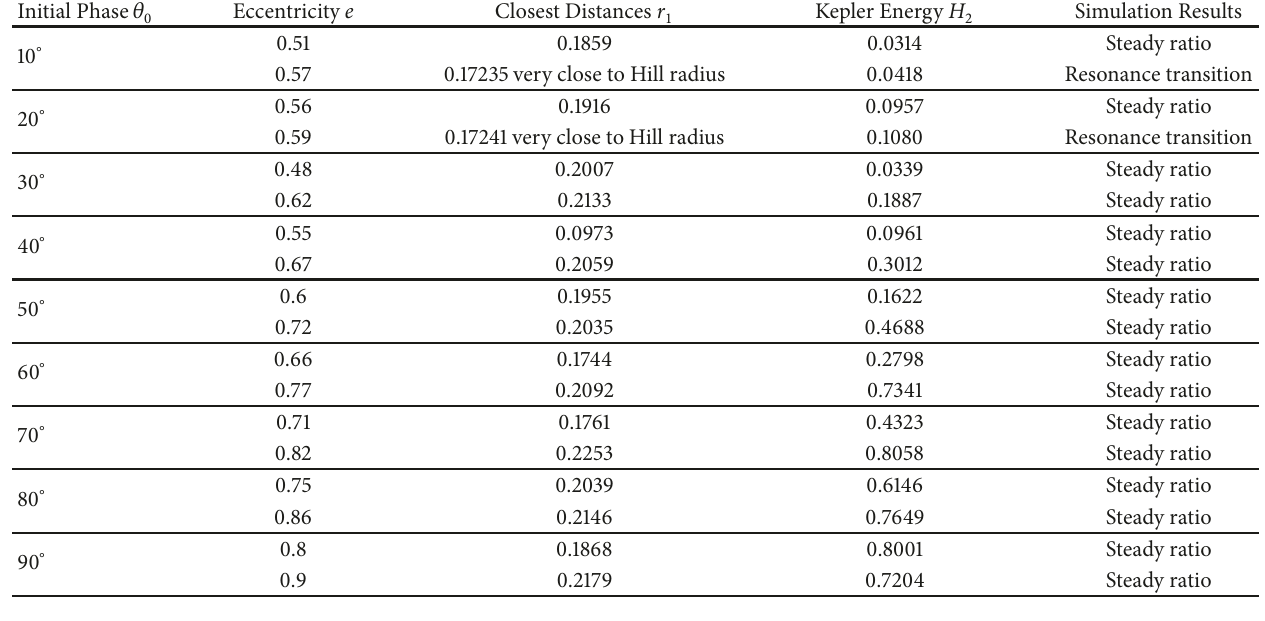
and temporary - ROI